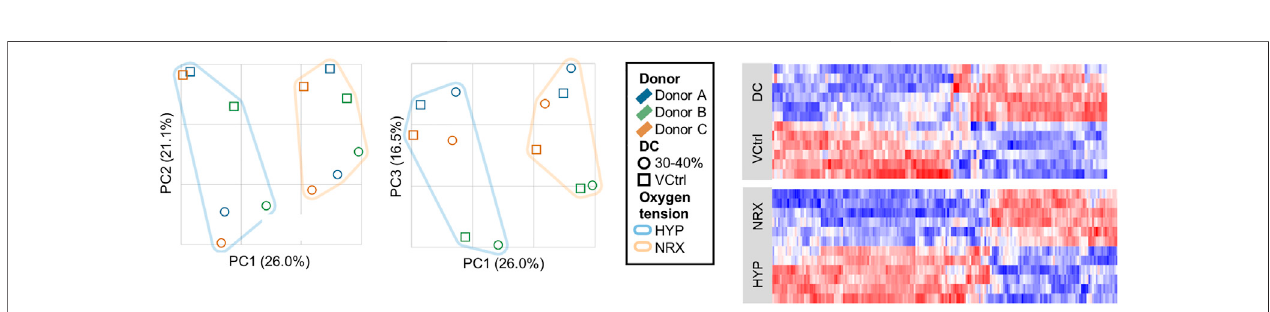
FIGURE 3 | Experiment I: Principal component analysis and heatmaps of the RNA-seq dataset from the 5-days mechano-hypoxia treatment. Expression was measured 30 min after the fi nal loading event. DC, dynamic compression; HYP, hypoxia; NRX, normoxia; PC, principal component; VCtrl, static vehicle control.